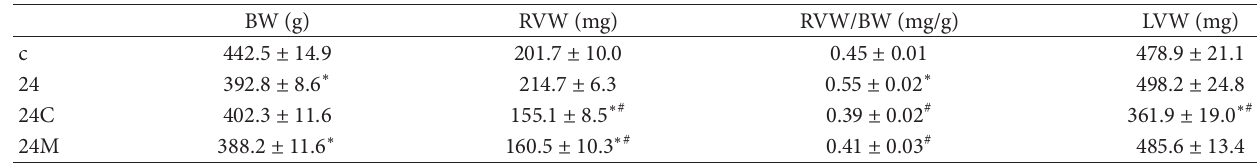
Values are mean ± SEM, ∗ 𝑃 < 0.05 versus c, # 𝑃 < 0.05 versus